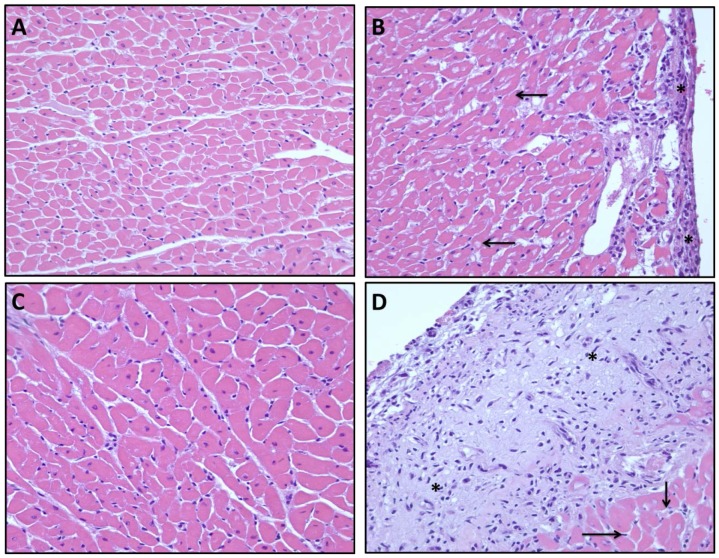
Cross section (40X) of normal cardiac myocytes from vehicle+vehicle group.(A), vehicle+celecoxib group showing a mild organizing pericarditis (*) and adjacent normal cardiac myocytes (arrow) (B), normal cardiac myocytes from misoprostol+misoprostol group (C), misoprostol+celecoxib group showing a severe organizing pericarditis (*), and adjacent normal cardiac myocytes (arrow) (D).